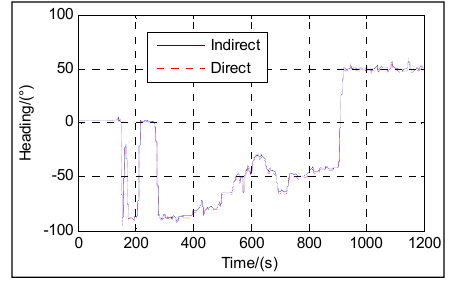
Figure 7. Heading. Figure 7. Heading.